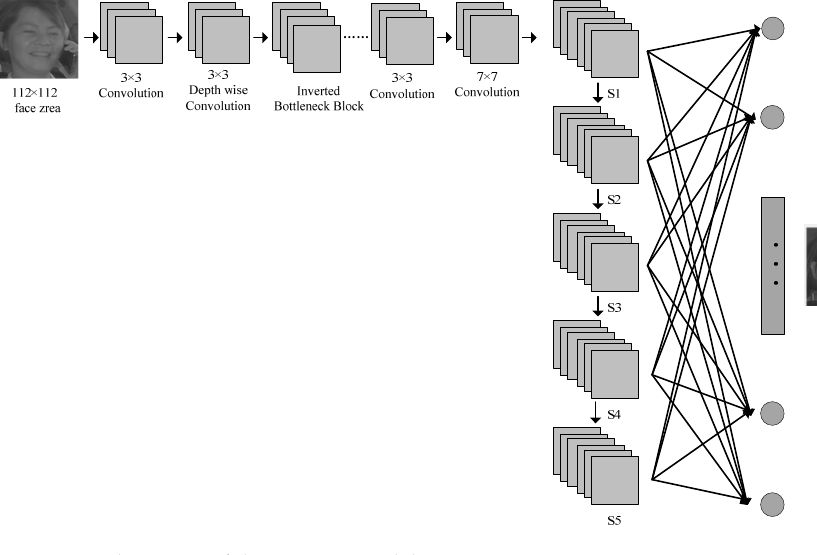
Figure 3. Architecture of the MSFLD model.